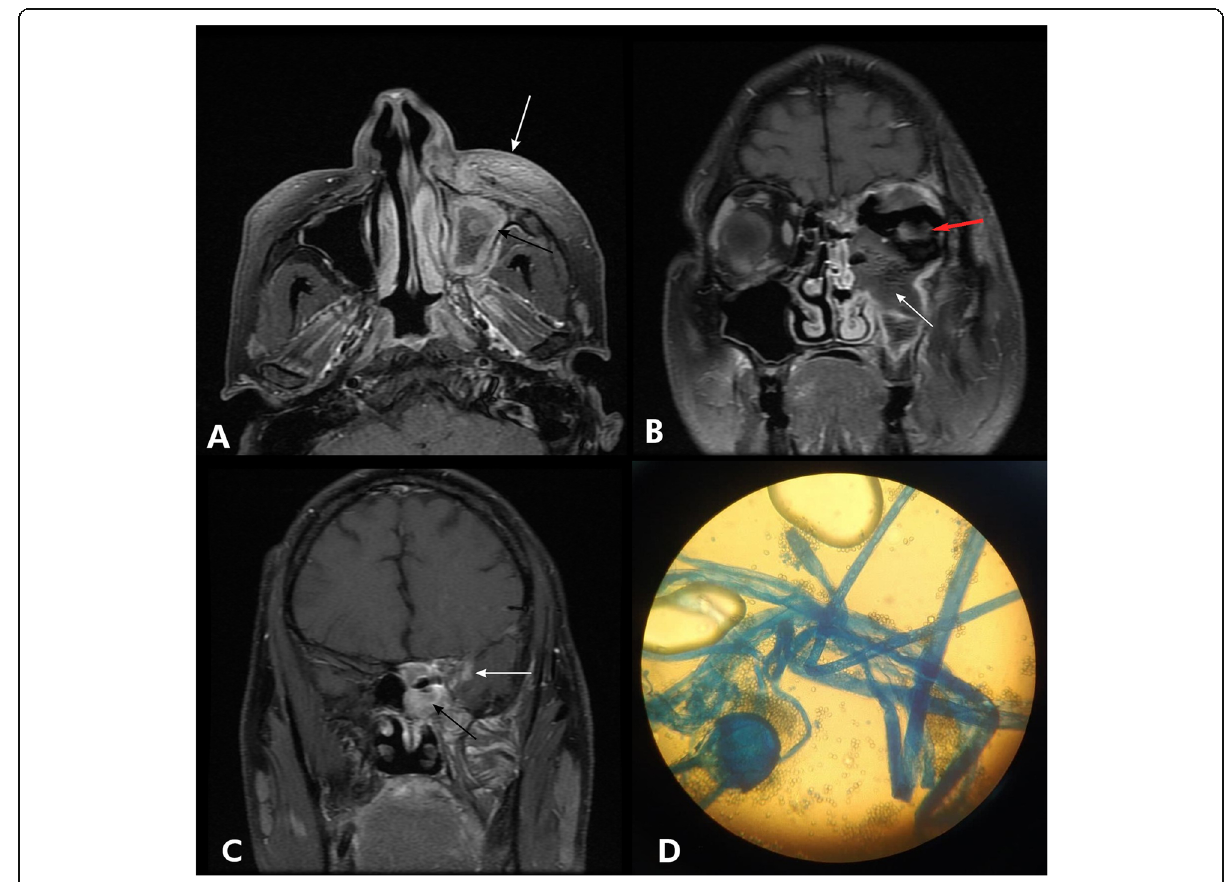
Fig. 4 a Axial T1 post-contrast image showing mucosal thickening and collection involving left maxillary sinus (black arrow) with pre-maxillary soft tissue swelling (white arrow). b Axial T1 post-contrast image showing inferior orbital wall with extension of soft tissue component into left inferomedial orbit (white arrow) and left phthisis bulbi (red arrow). c Coronal T1 post-contrast image showing left sphenoid sinusitis (black arrow) with an area of enhancement involving left medial temporal lobe (white arrow). d Lactophenol cotton blue (LPCB) stain showing broad aseptate ribbon-like hyphae with